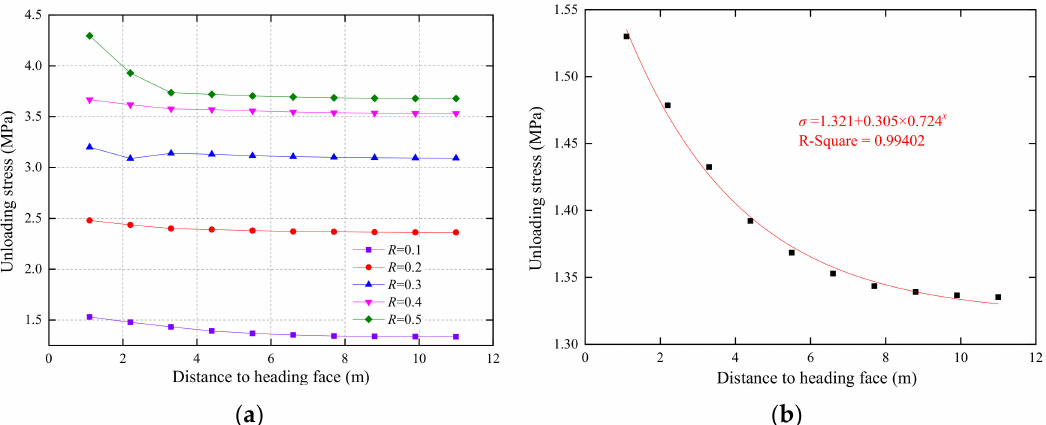
Figure 11. The unloading disturbance stress distribution law of the roadway heading under different driving speeds: ( a ) the unloading disturbance stress distribution curve of the roadway heading under different driving speeds; ( b ) the fitting function and curve of unloading disturbance stress of the roadway heading when R = 0.1. Table 3. The fitting function of unloading disturbance stress of the roadway head-on cutting under different driving speeds. Driving Speed Fitting